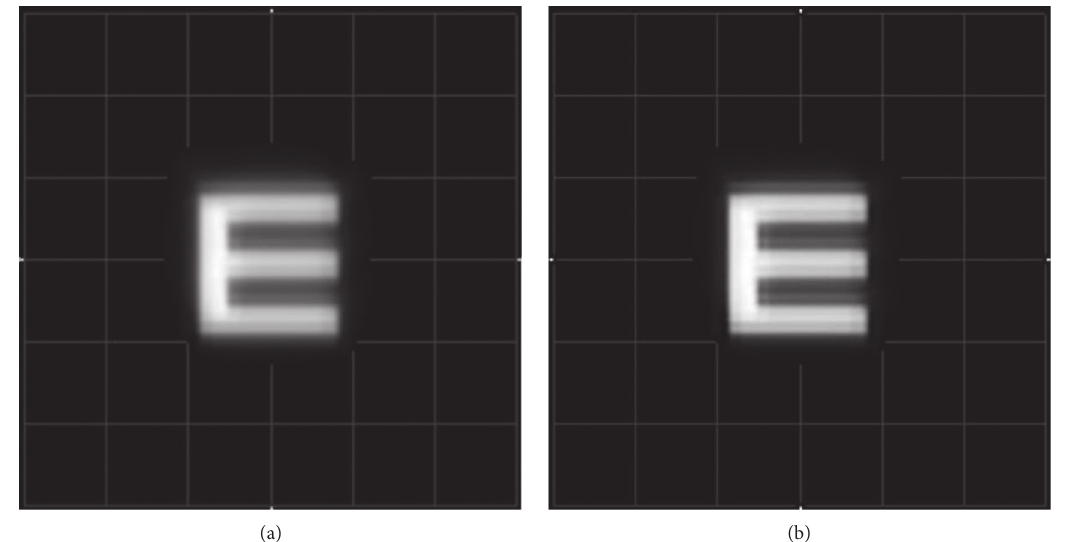
Figure 6: Simulated visual acuity images from the aberrometry measurements of a patient treated with topical ciclosporin A before (a) and after therapy (b).